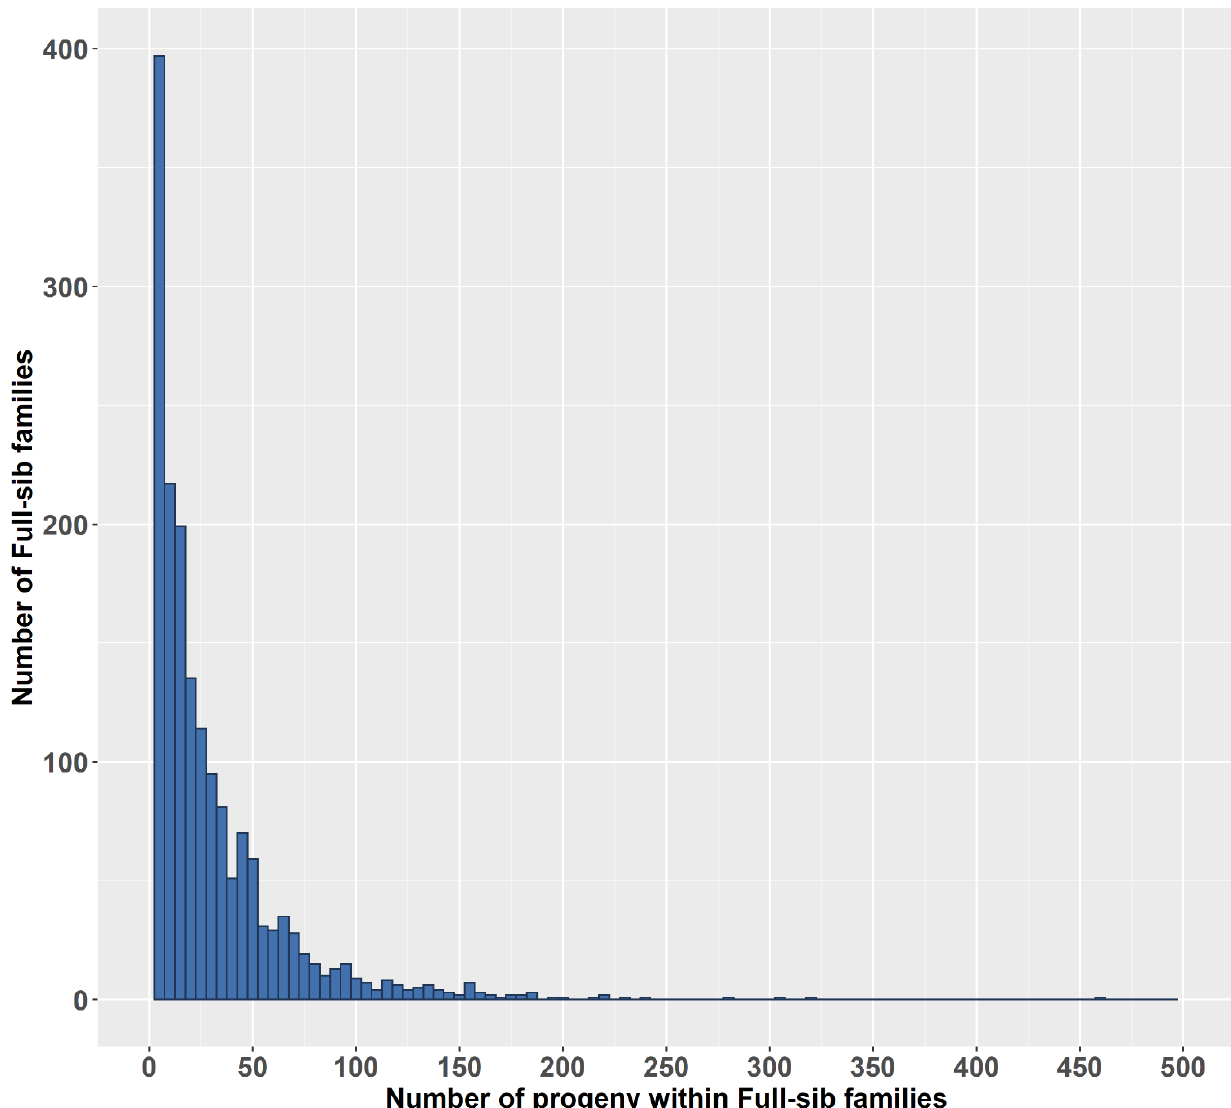
Figure 3. Numbers of full-sib families and their numbers of progeny.